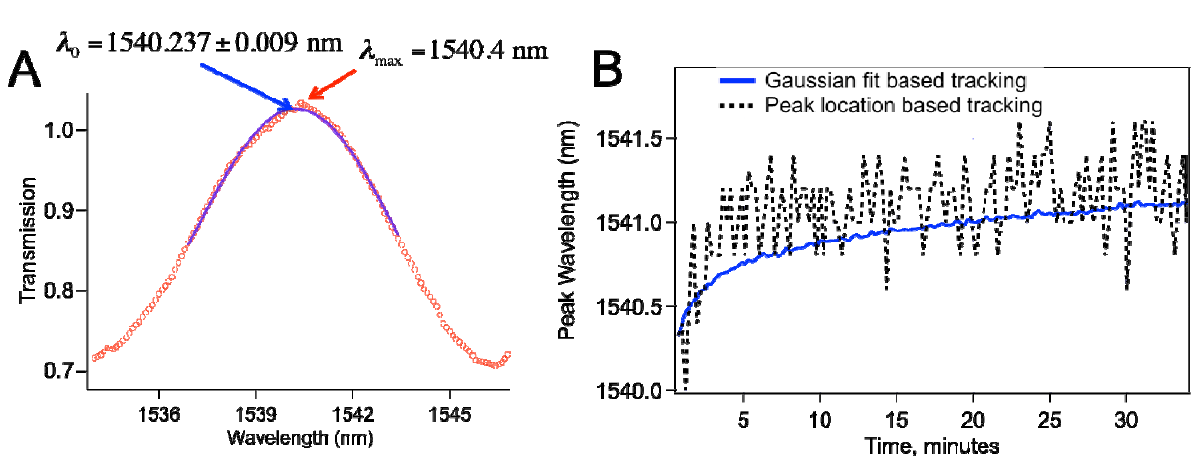
Figure 3. ( a ) Gaussian fitting to the data leads to determination of the peak with better precision; ( b ) Comparison of the peak wavelength vs. time plot based on Gaussian fit based tracking and that with peak location search based